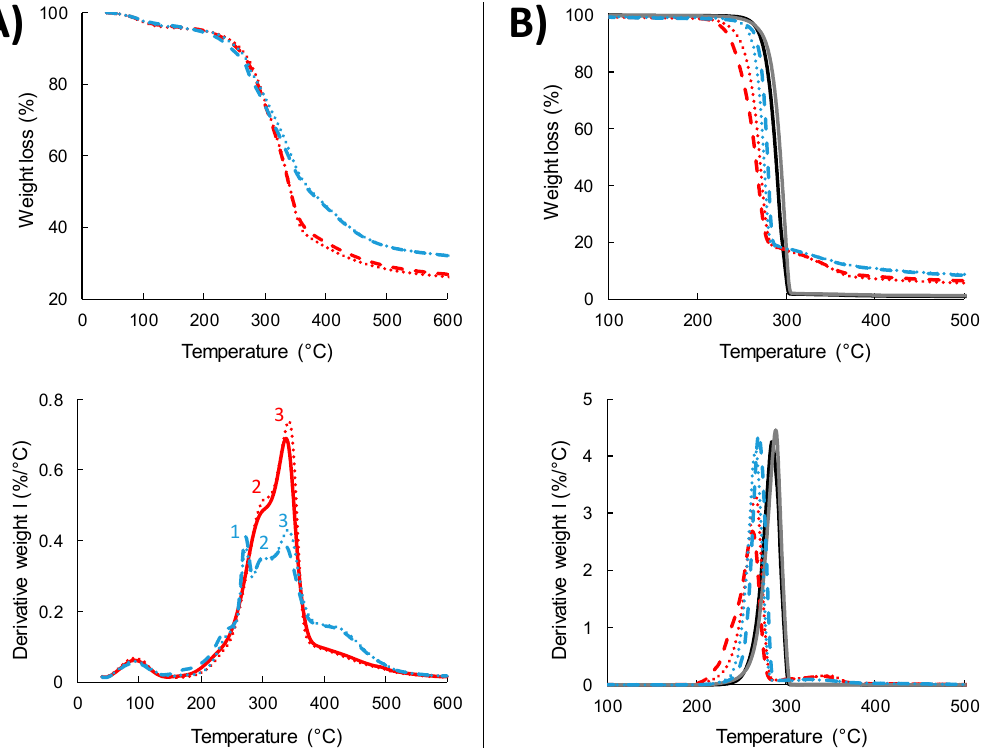
Figure 3. Thermogravimetric analysis of ( A ) the fillers: ViSh-V (- -), ViSh-E ( · · ), WiPo-V (- -) and WiPo-E ( · · ) and ( B ) the composites: PHBV-ref 1 ( — ), PHBV-ref2 ( — ) 20ViSh-V (- -), 20ViSh-E ( · · ), 20WiPo-V (- -) and 20WiPo-E ( · · ) under nitrogen. Table 3. Results from the thermogravimetric analysis under N 2 of the ViSh and WiPo fillers.